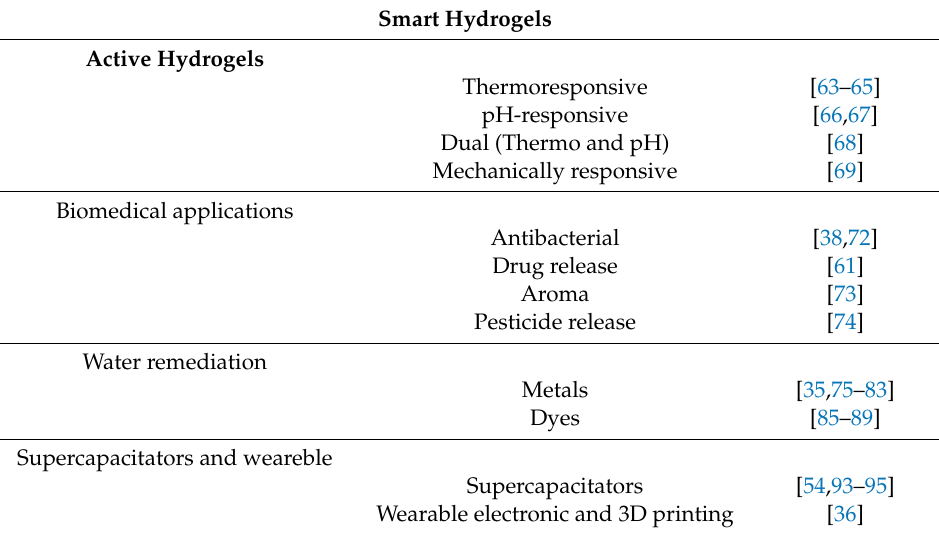
Table 2. Main applications of lignin-based